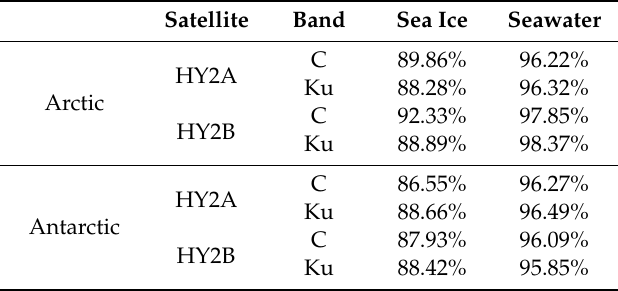
Table 3. Average classification accuracy.